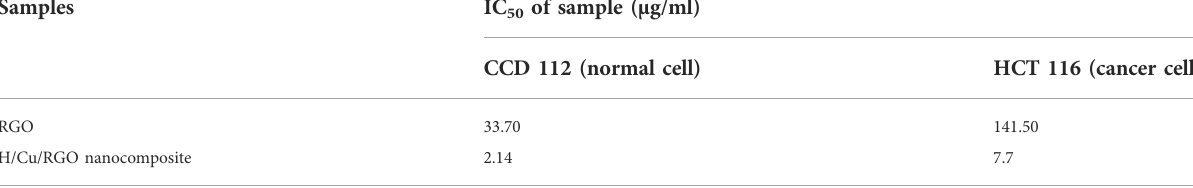
TABLE 2 IC 50 of the RGO and nanocomposite toward normal and cancer cell lines of the colorectal cell.